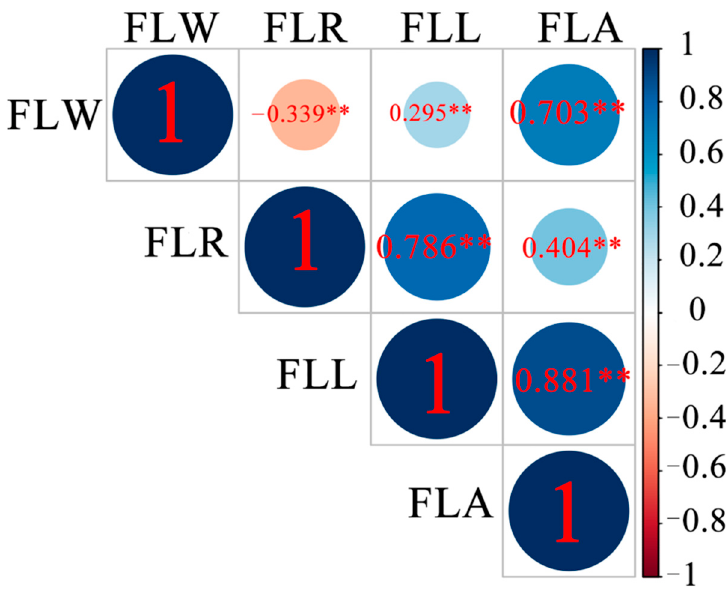
Figure 3. Correlation analysis of flag leaf shape in 173 rice accessions. **, significant differences at p < 0.01.